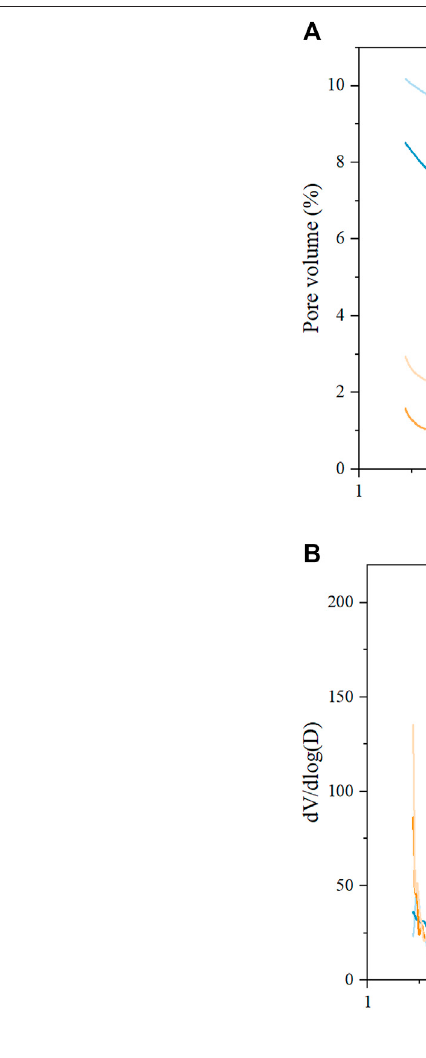
Frontiers in Materials |